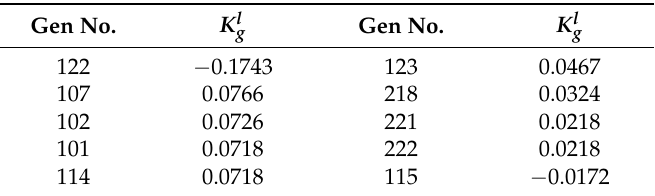
Table 3. Calculation result of sensitivity.